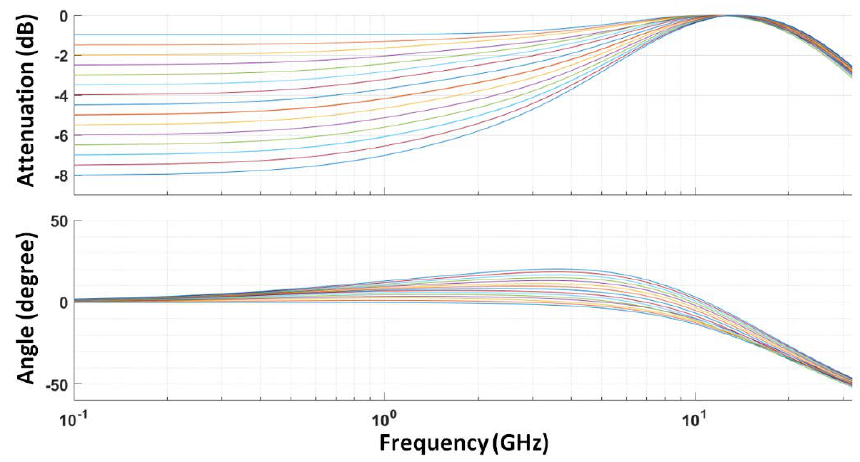
Figure 4. Typical response curve of the continuous time-domain linear equalizer (CTLE) as defined in Reference [4] in 0.5 dB step size.